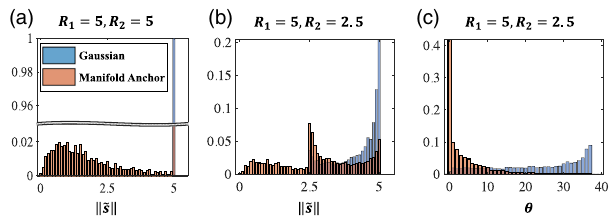
FIG. 6. Distribution of k ˜ s k (norm of manifold anchor vectors) and θ ¼ ∠ ð − ⃗ t; ˜ s Þ for D ¼ 2 ellipsoids. (a) Distribution of ˜ s for an l 5 . The Gaussian geometry is peaked at k ˜ s k ¼ r 2 ball with R ¼ (blue), while k ˜ s k < r has nonzero probability for the manifold anchor geometry (red). (b),(c) D ¼ 2 ellipsoids, with radii R 1 ¼ 5 R 1 . (b) Distribution of k ˜ s k for Gaussian geometry and R 2 ¼ 1 2 (blue) and anchor geometry (red). (c) Corresponding distribution of θ ¼ ∠ ð − ⃗ t; ˜ s Þ